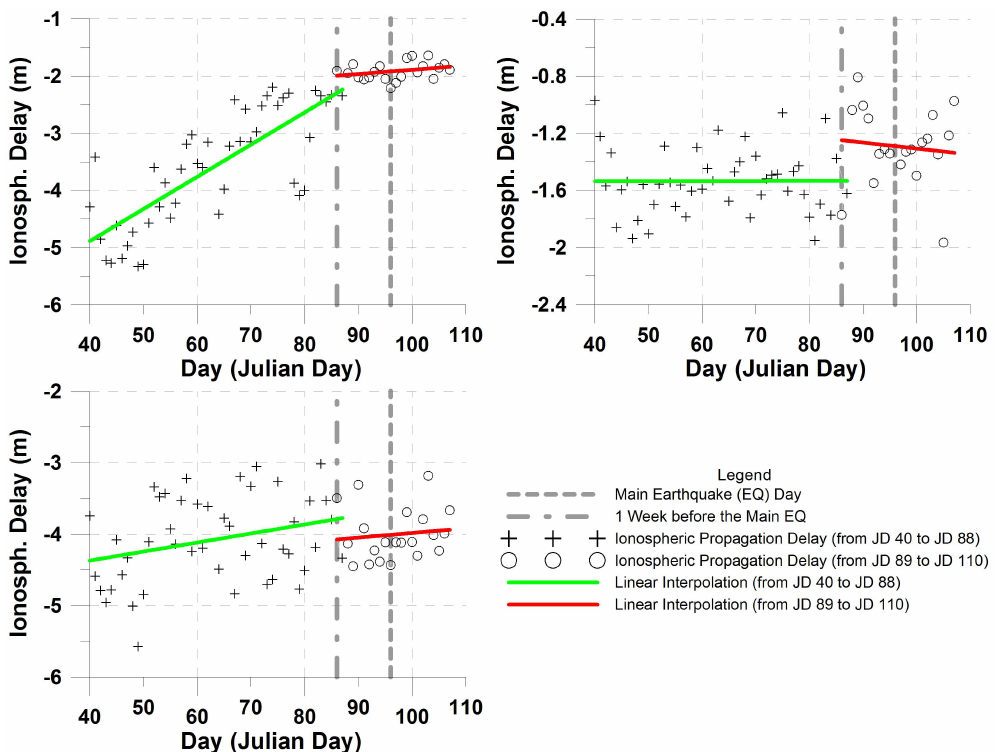
Fig. 8. Time series of the ionospheric delay in AQUI–PRN 8 (top left), PRN 29 (top right) and PRN 11 (bottom left).